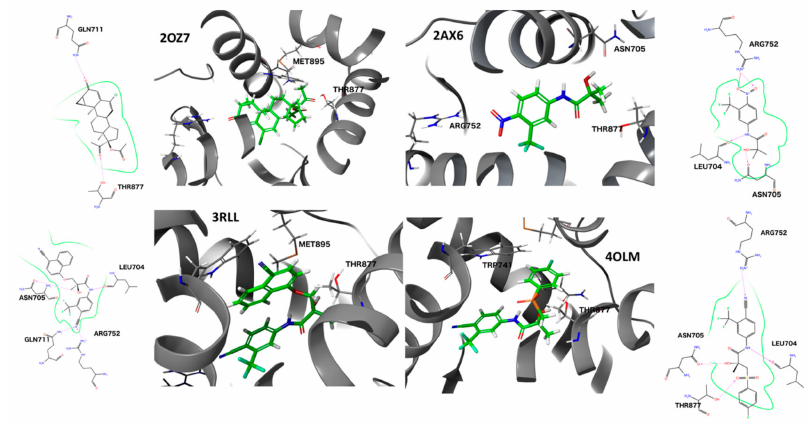
Figure 4. Docking poses of AR antagonists at AR wild type (WT) obtained from induced fit docking (IFD) and binding pose